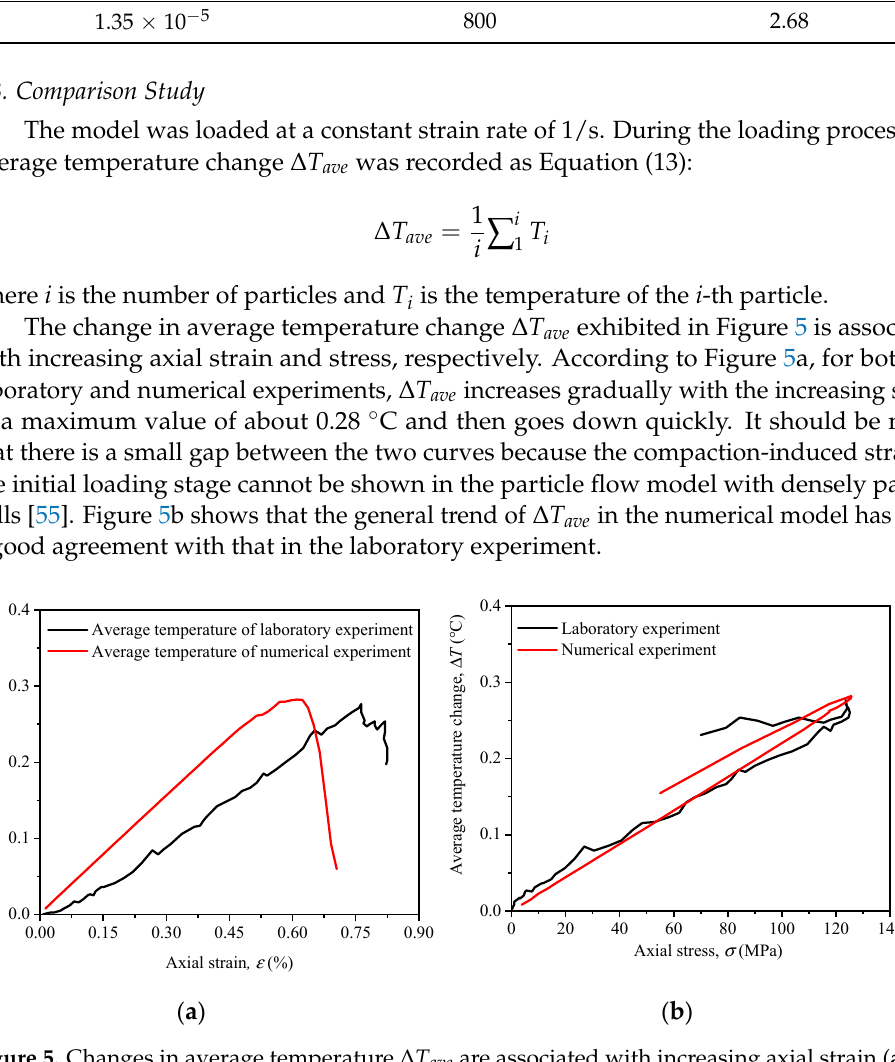
Table 2. Thermal parameters of the granite thermodynamic model [based on [54]]. Thermal Expansion Coefficient